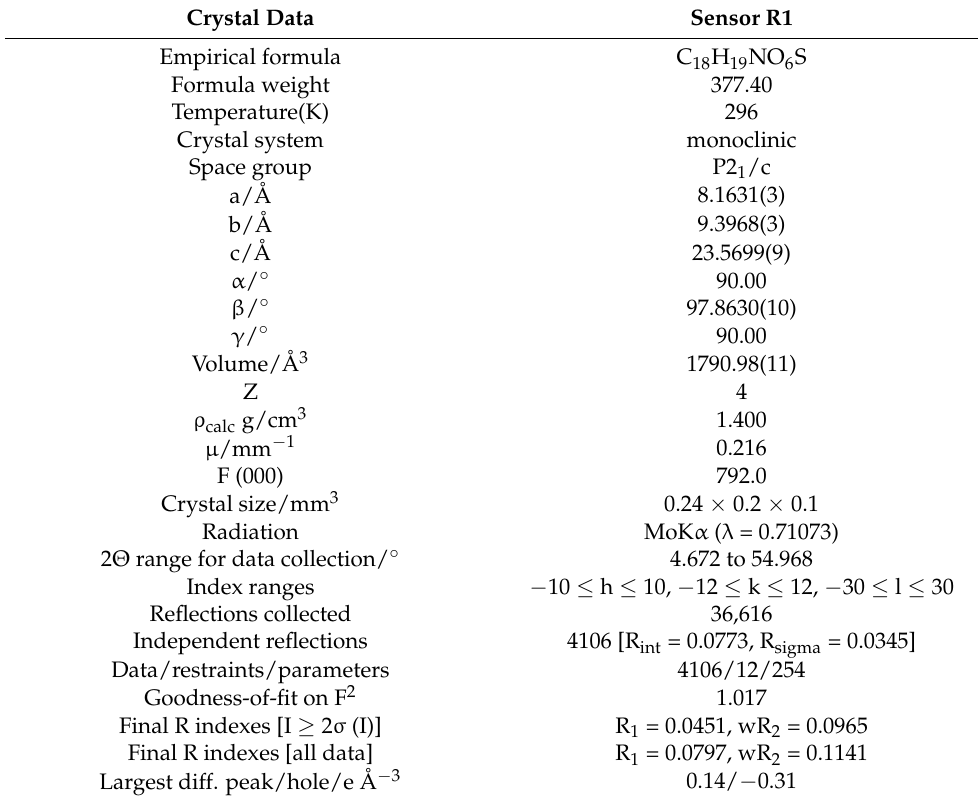
Table 1. Crystal data and structure refinement parameters for sensor R1.